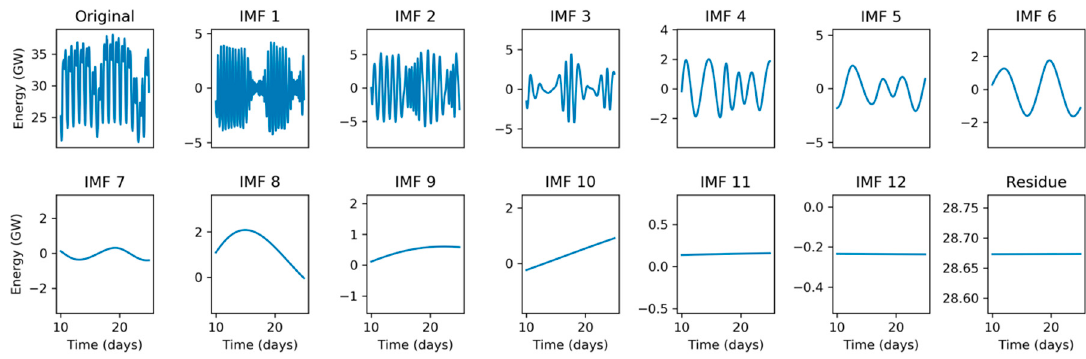
Figure 9. Empirical Mode Decomposition of the electricity demand: Daily scale.